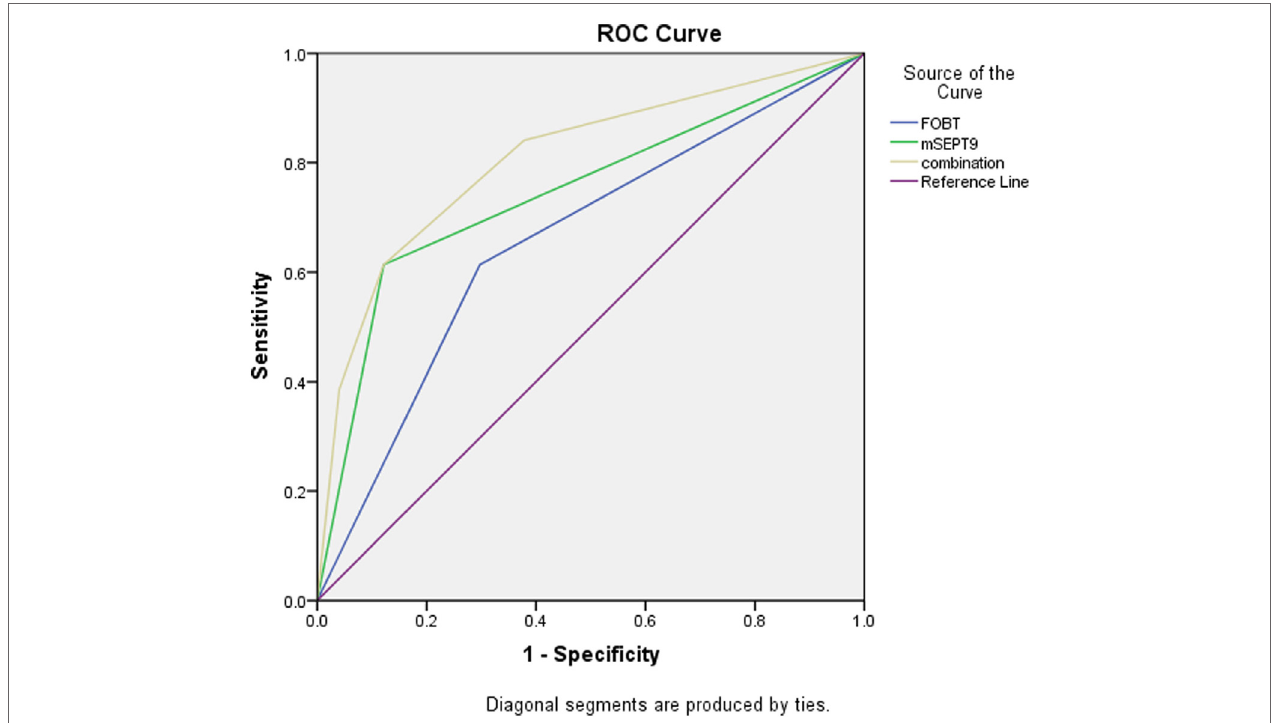
FigUre 1 | Receiver operating characteristic (ROC) curve of fecal occult blood test (FOBT), methylated Septin9 ( mSEPT9 ), and the